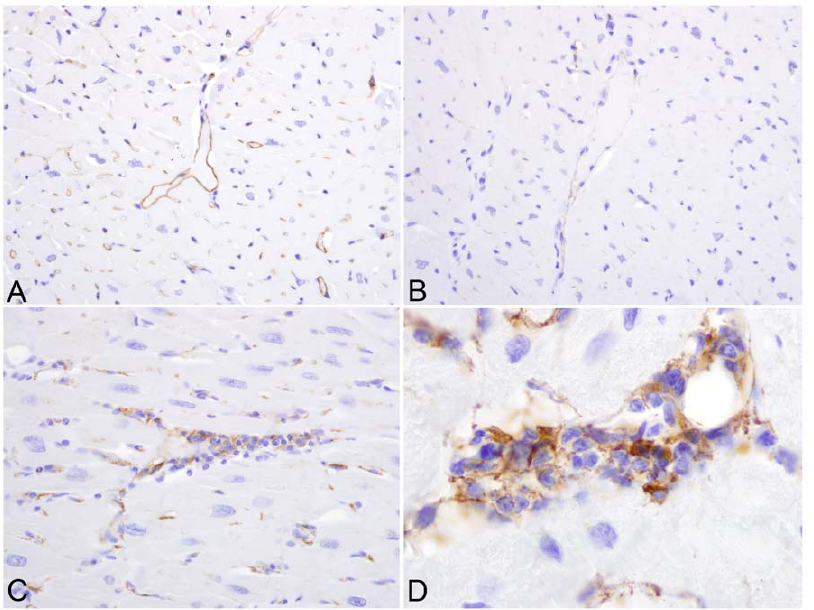
Figure 7. ICAM-1 expression in myocardial sections. IHC for ICAM-1, localizing increased ICAM-1 expression to endothelial cells in non- inflamed myocardium of SIV positive, untreated rhesus macaques (A) as opposed to SIV infected monkeys that received CART (B). Increased ICAM-1 expression was also localized to mononuclear inflammatory cell infiltrates in animals that received antiretroviral therapy (C). Higher magnification of inflammatory foci (1,000X) (D). Immunoperoxidase immunohistochemistry, with DAB chromogen (brown) and hematoxylin counterstain.